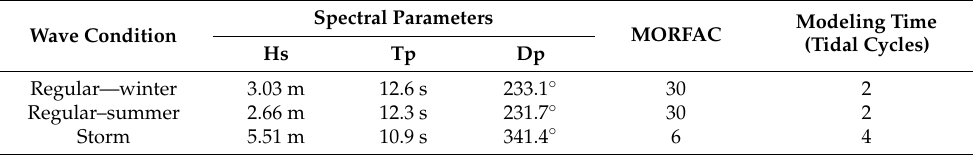
Figure 3. Nested and detailed grids used in the numerical model with Delft 3D. Vertical scale shows depth in m; horizontal scale shows length in km. Table 2. Wave parameters (deep water), MORFAC, and modeling times used for the numerical simulations.